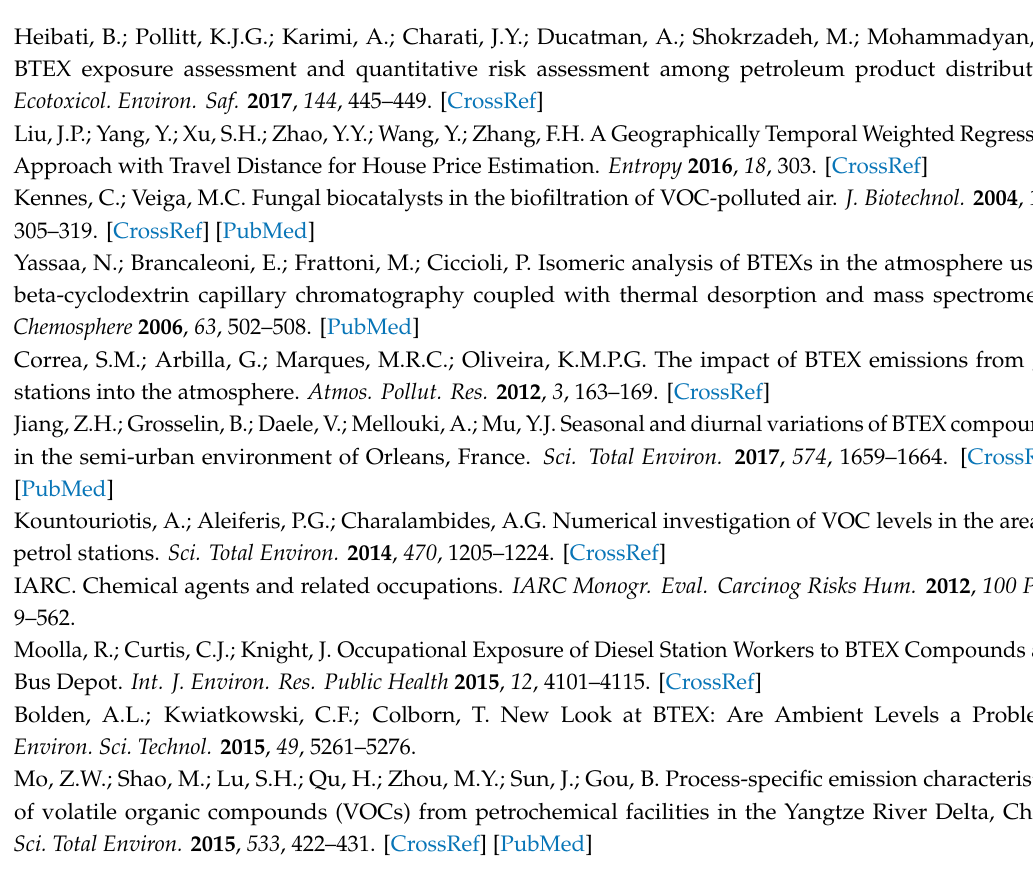
Figure S1: Overview of the sampling sites (1–17) and wind rose diagrams for the study periods of spring, summer, fall and winter, Table S1: Parameters proposed in hybrid-kriging LUR coupled with RF models, Table S2: Parameters proposed in hybrid-kriging LUR coupled with XGBoost models, Table S3: Parameters proposed in hybrid-kriging LUR coupled with XGBoost models, Table S4: Results of 10-fold cross-validation proposed in the XGBoost- Hybrid LUR